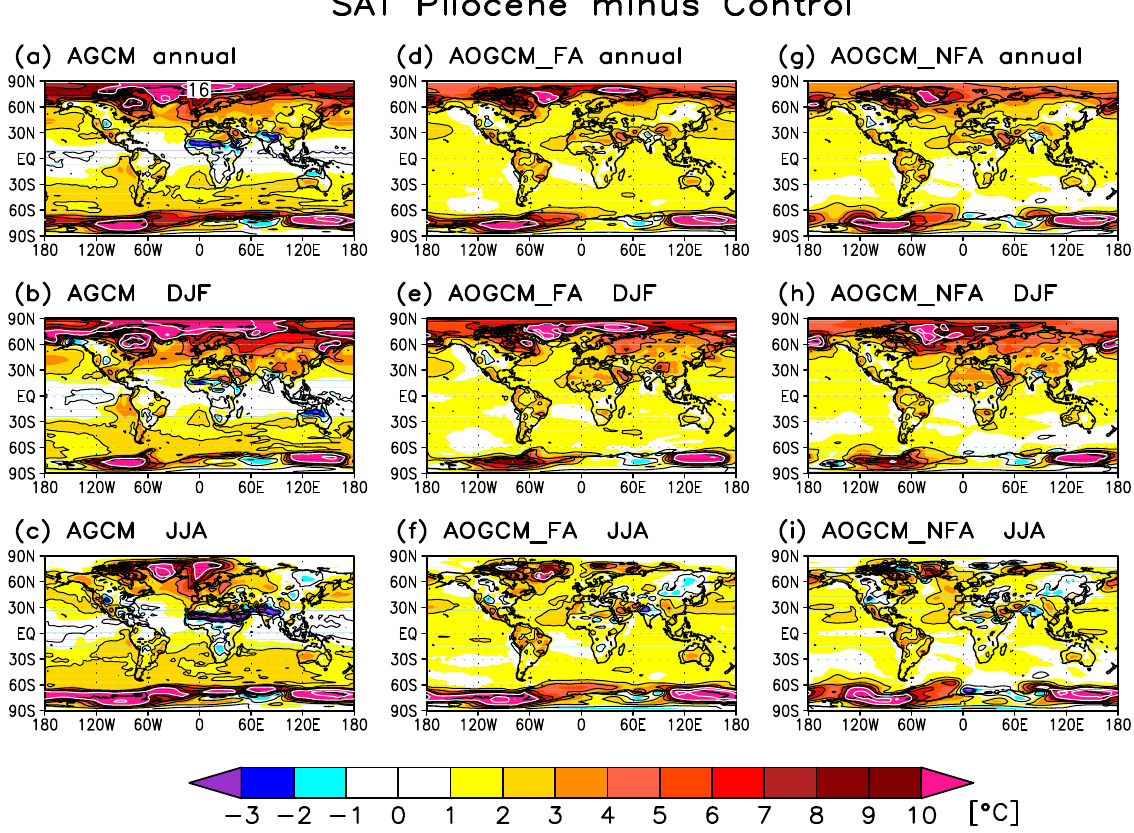
Fig. 5. Difference of SAT ( ◦ C) between Pliocene and Control. (a, b, c) AGCM, (d, e, f) AOGCM with flux adjustment (AOGCM FA), and (g, h, i) AOGCM without flux adjustment (AOGCM NFA). Black and white contours represent ± 2, 4, 6, 8 ◦ C and ± 10, 16 ◦ C, respectively. (a, d, g) Annual, (b, e, h) December, January and February (DJF) and (c, f, i) June, July and August (JJA) mean field.